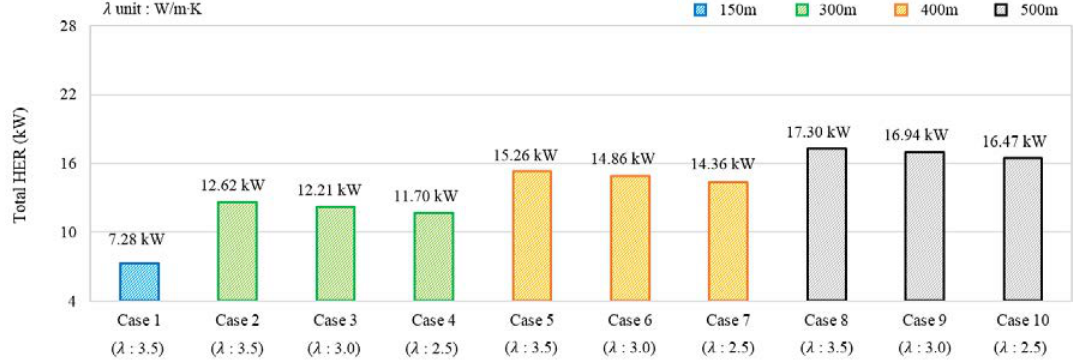
Figure 8. Total HER per borehole according to the thermal conductivity and the length of the